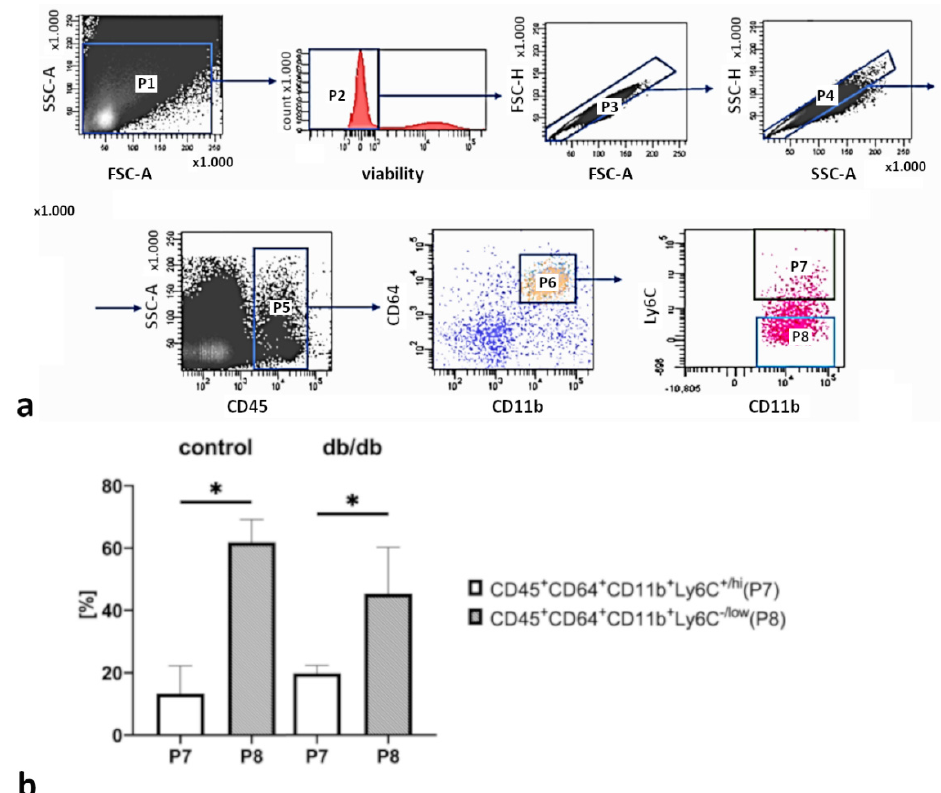
Figure 3. Sorting strategy ( a ) and macrophage subpopulations count in db/db and control mice ( b ). Gates: P1—whole cell count after enzymatic digestion of cardiac tissue; P2—viable cells; P3 and P4—doublet exclusion; P5—CD45 + ; P6—CD45 + CD11b + CD64 + . Finally, two populations were gated: P7—CD45 + CD63 + CD11b + Ly6C +/hi and P8—CD45 + CD63 + CD11b + Ly6C +/low . Values are mean ± S.E. ( n = 6); *, p < 0.05 versus control group as determined by Wilcoxon signed-rank